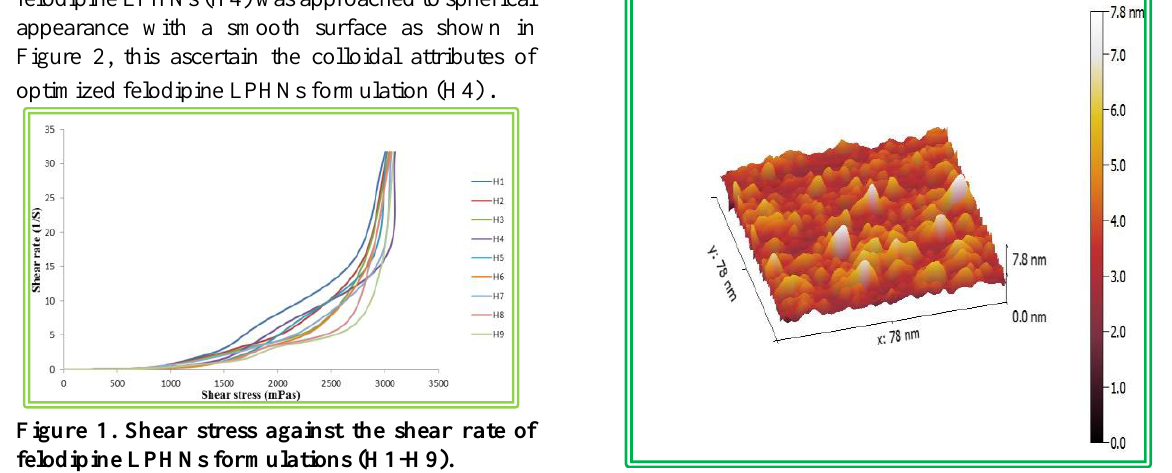
Figure 2. The AFM 3D image of felodipine LPHNs (H4) where the scanning area is 78 nm * 78 nm